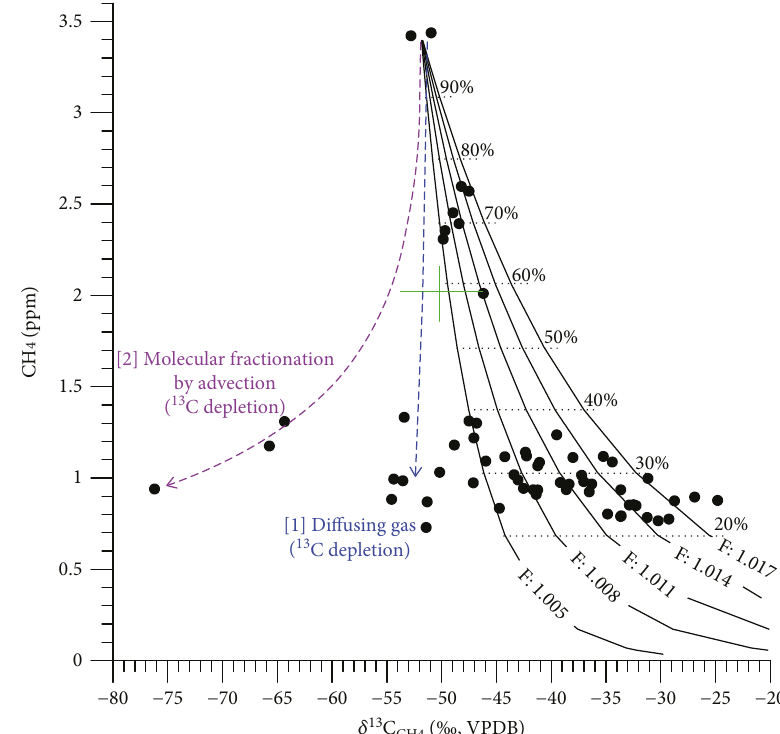
Figure 7: Relationship between CH and δ 13 C-CH in underground air of Vapour Cave (VC; closed circles). The standard composition of the 4 4 localbackgroundatmosphereisindicatedbythegreencrosshairs(asareference,the δ 13 C valueofthiscrosshairsseparatestheCH involved CH4 4 in bacterial oxidation from CH coming from other sources). Continuous curves show the locus of compositions formed by methanotrophic 4 consumption of atmospheric methane modelled as a Rayleigh process using several kinetic fractionation factors ( F : from 1.005 to 1.017). Horizontal dotted lines with labels show the percentage of deep endogenous methane remaining in cave air after methanotrophic consumption. Curves for isotopic fractionation by di ff usion and molecular fractionation by advection are only inferred, but not